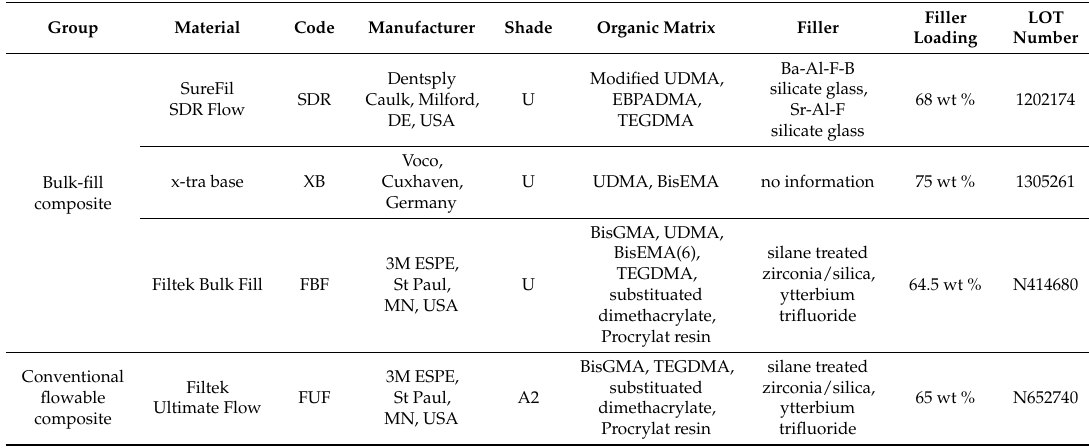
Table 1. Materials, manufactures and